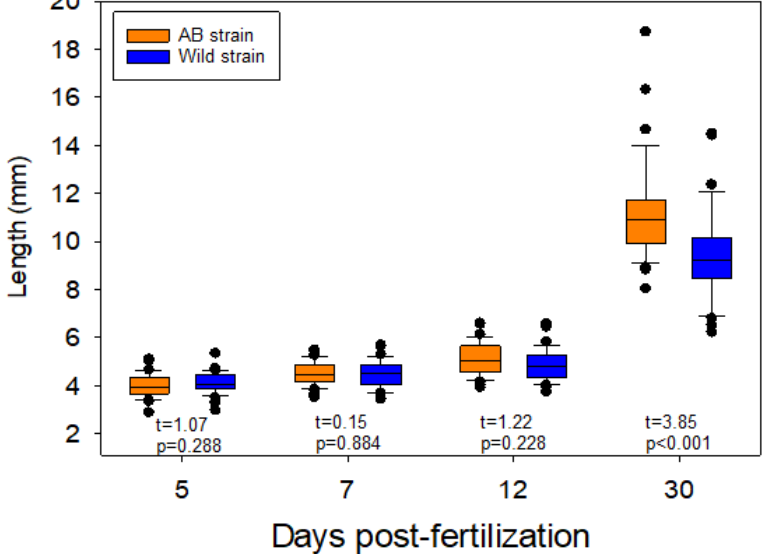
Figure 2. Boxplots showing the length for the larvae/juveniles for the different days post fertilization.